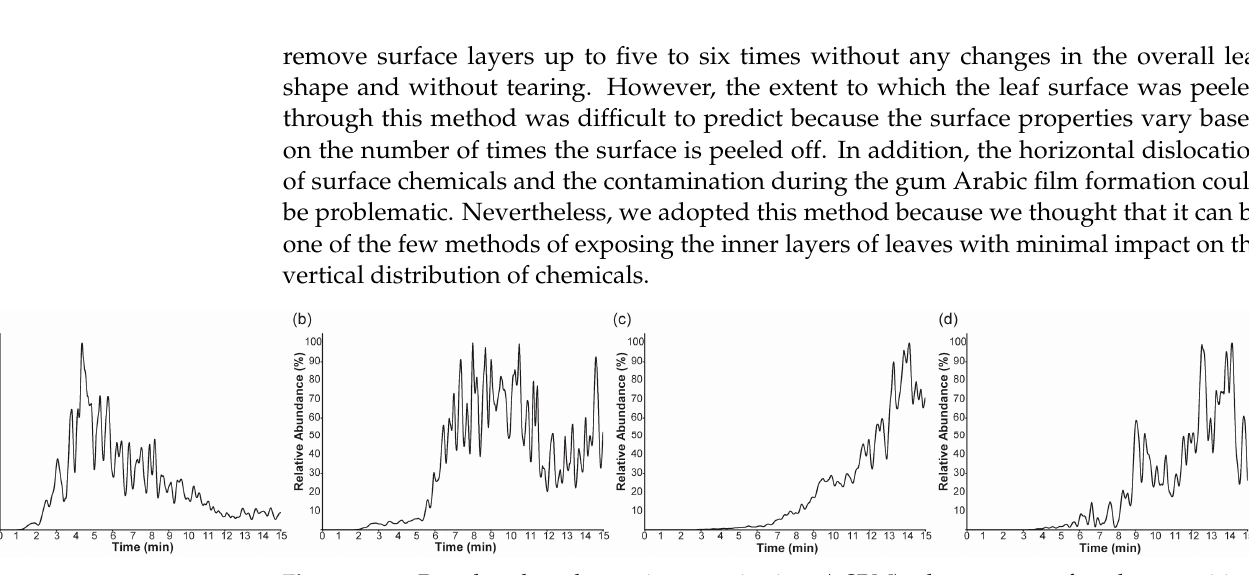
Figure 5. Psuedo-selected reaction monitoring (pSRM) chronograms for the transitions ( a ) m / z 447 → m / z 301, ( b ) m / z 535 → m / z 466, ( c ) m / z 549 → m / z 480, and ( d ) m / z 569 → m / z 309 obtained directly from a Hypericum leaf surface by nano-DESI MS. The normalized collision energy values were set to 30% for ( a – c ) and 35% for ( d ).